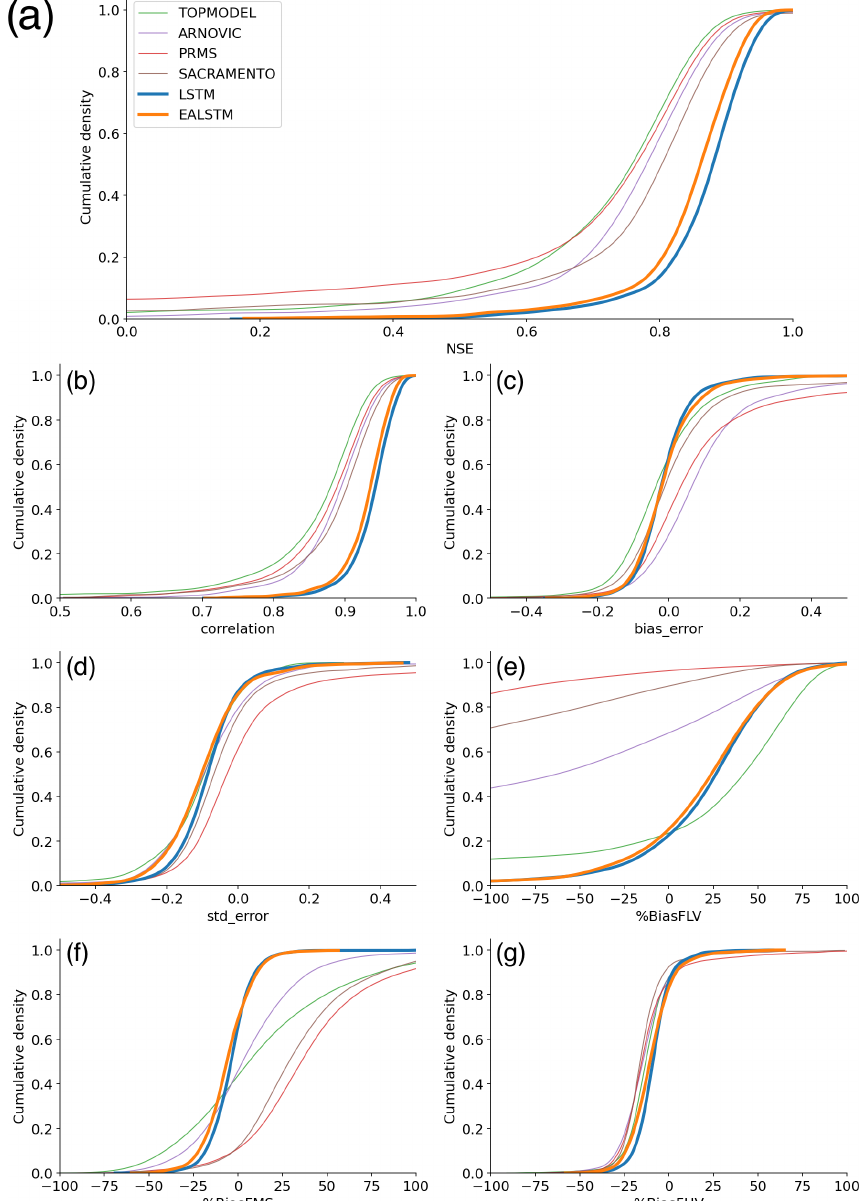
Figure 1. Cumulative distribution functions (CDFs) of station goodness-of-fit metric scores for each model. EA LSTM (orange) and the LSTM (blue), as well as the conceptual models: TOPMODEL (green), VIC (red), PRMS (purple) and SACRAMENTO (brown) (Lane et al., 2019). Panels indicate the distribution of stations: (a) NSE scores, (b) correlation scores, (c) bias error scores, (d) variability error scores, (e) low-flow bias scores, (f) mid-range of flow bias scores and (g) high-flow bias